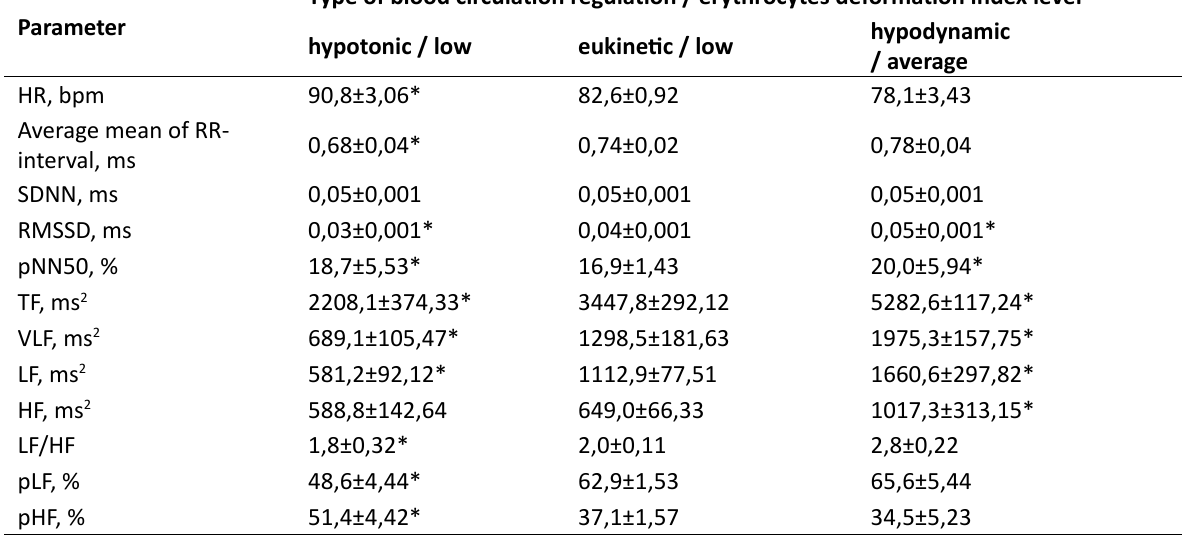
Table 3. Value of parameters of heart rate variability of female volleyball players with a different type of blood circulation and value of erythrocytes deformation index after the physical activity of the maximum aerobic productivity